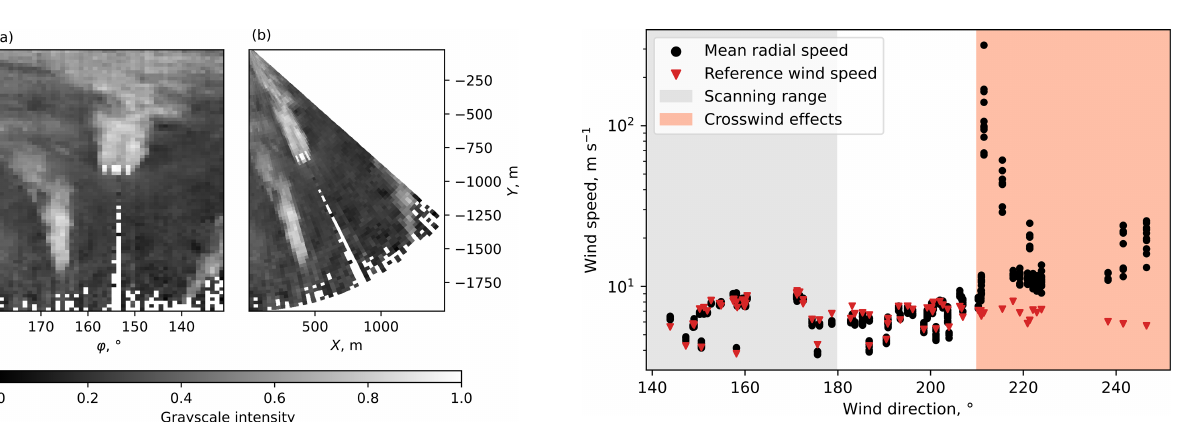
Figure 2. An example lidar scan 497 taken on 24 September 2016 19:18:20UTC + 0 at reference wind speed 7.4ms − 1 and reference wind direction 151.14 ◦ . The original data are presented in (a) the polar coordinates R , ϕ as stored in the matrix and (b) the Cartesian coordinates X , Y .